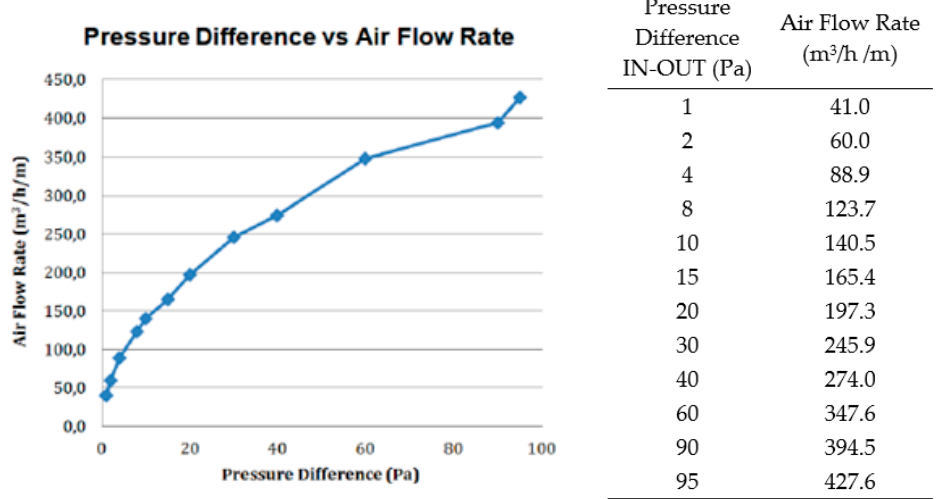
Figure 15. Performance of Metal Yapi horizontal Trickle Vents [14].